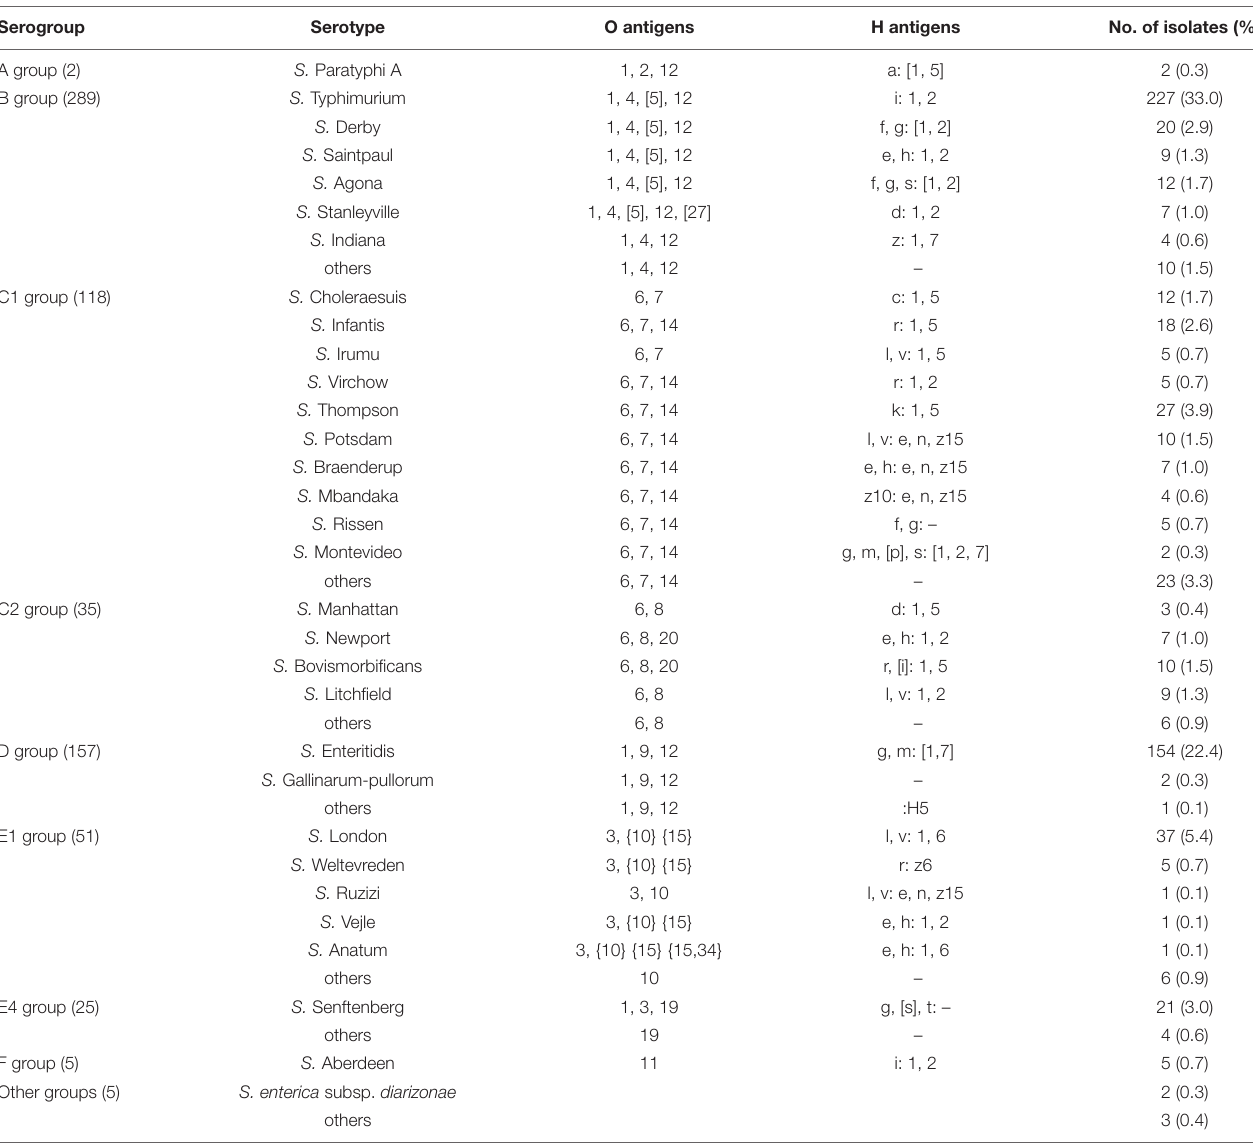
TABLE 1 | Serotype distribution of 679 Salmonella isolates. Serogroup